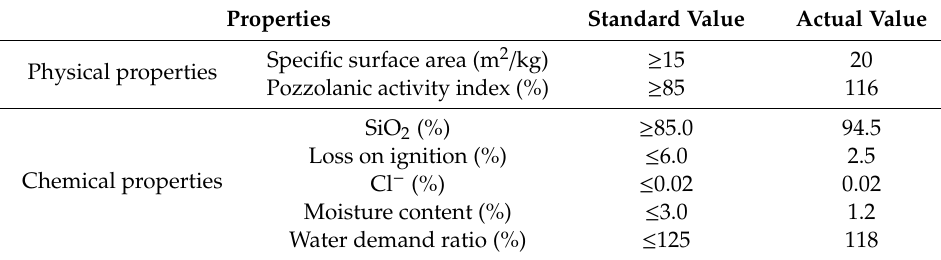
Table 2. Physical and chemical properties of silica